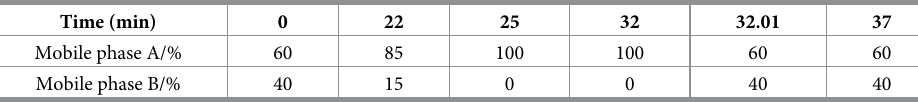
Table 1. Liquid phase gradient elution